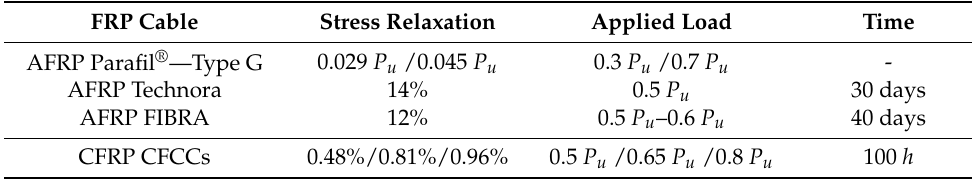
Table 4. FRP composite tendons: relaxation properties.